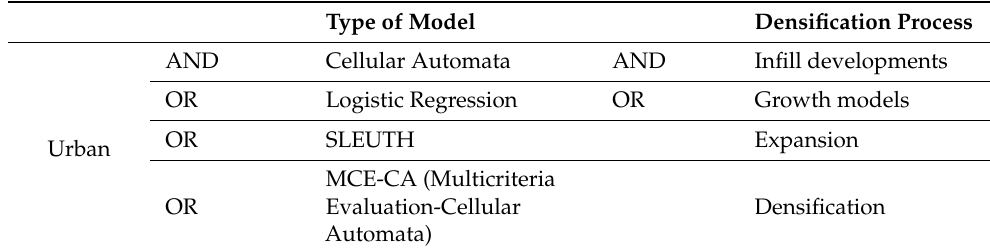
Table 1. Keyword combination of systematic literature search .